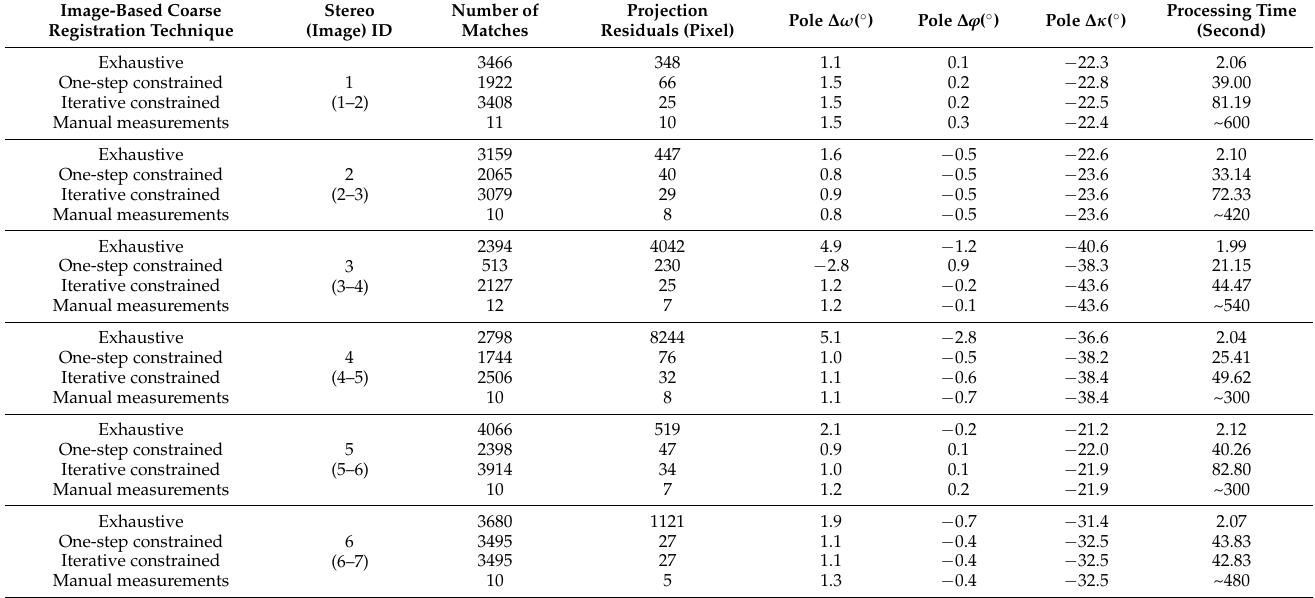
Table 4. Performance comparison of the traditional and proposed image matching techniques in terms of number of matches, processing time, projection residual, and estimated relative pole rotations for the station in the US-231